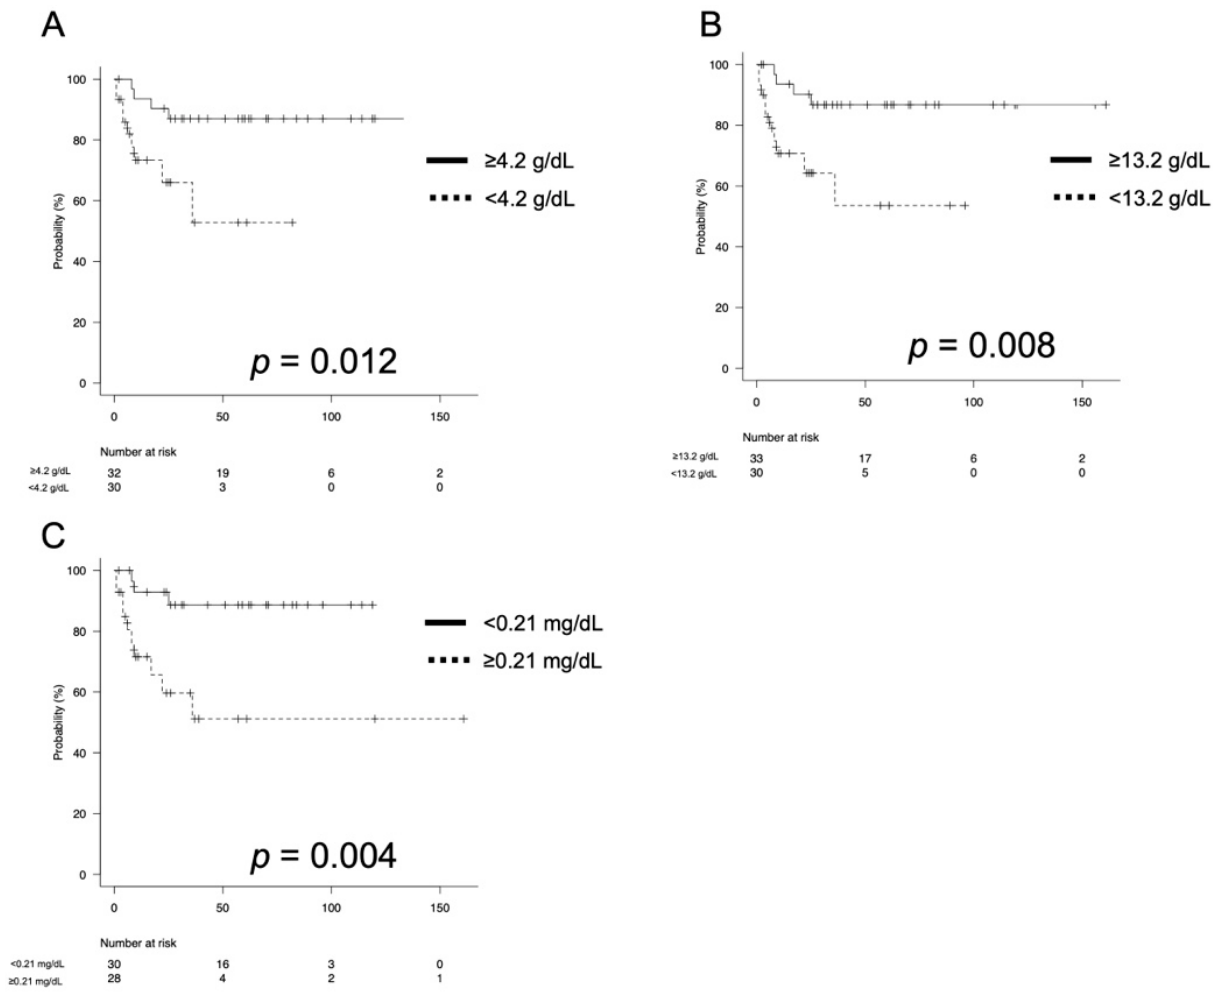
Figure 1. The Kaplan–Meier estimates of cancer-specific survival (CSS) according to serum albumin (Alb) levels stratified by a cutoff of 4.2 g/dL ( A ), hemoglobin (Hb) levels stratified by a cutoff of 13.2 g/dL ( B ) and C-reactive protein (CRP) levels stratified by a cutoff of 0.21 mg/dL ( C ). The 2-year CSS rates were 90.3% and 66.0% among patients with Alb levels of ≥ 4.2 g/dL and <4.2 g/dL, respectively ( p < 0.012; Figure 1A); 90.2% and 64.3% among those with Hb levels of ≥ 13.2 g/dL and <13.2 g/dL, respectively ( p = 0.008; Figure 1B); and 92.9% and 59.7% among those with CRP levels of ≥ 0.21 mg/dL and <0.21 mg/dL, respectively ( p = 0.004; Figure 1C). The 2-year CSS rates were 94.2% and 54.0% for clinical ≤ T2 and ≥ T3,